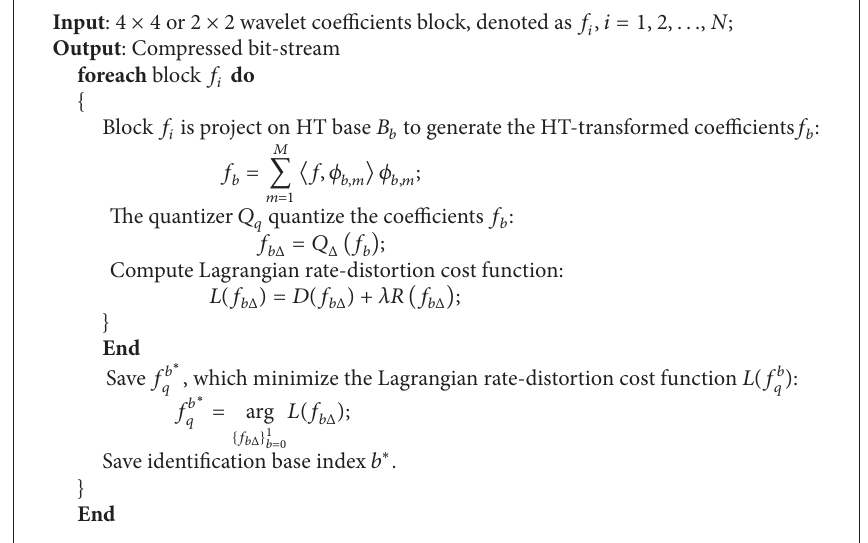
Algorithm 1: The HT-transform algorithm for one block.